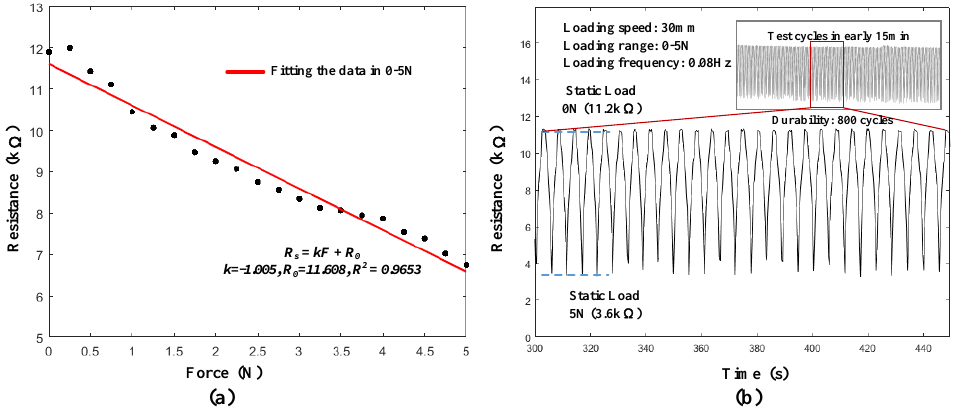
Figure 6. The calibration and stability testing of the tactile sensor units: ( a ) the calibration of the tactile sensor units; ( b ) the stability and reproducibility testing of the tactile sensor